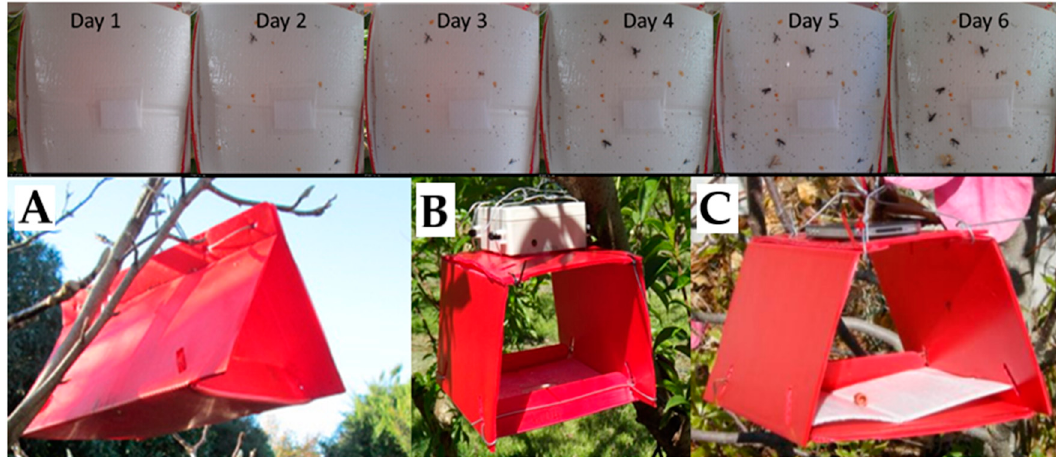
Figure 1. Camera traps tested with New Zealand flower thrips Thrips obscuratus , baited with peach lactone (6-pentyl-2H-pyran-2-one, 6-PAP) and used to upload cumulative daily catch photos (Top) for counting thrips by in-house software. ( A ) Standard Delta trap (T, each opening is 56 cm 2 ), ( B ) C, Camera trap (213 cm 2 openings with BioCamSR), ( C ) P, Smartphone-based prototype (244 cm 2 openings to achieve focal length). The 6-PAP sachet lure for T. obscuratus is visible on the bases (top). Images were loaded online as in the related example from the prototype camera trap system and software application, Pest Spy, https://bit.ly/3id5pjU.